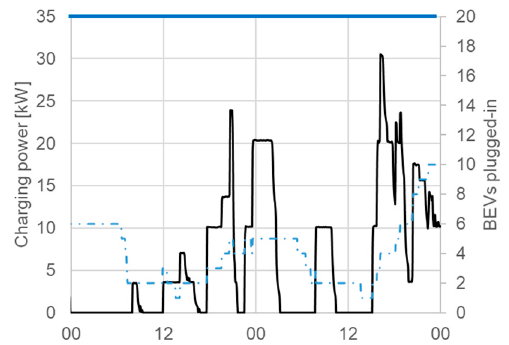
Figure 16. Load management with a maximum charging capacity of 35 kW (1.3 kW / BEV).